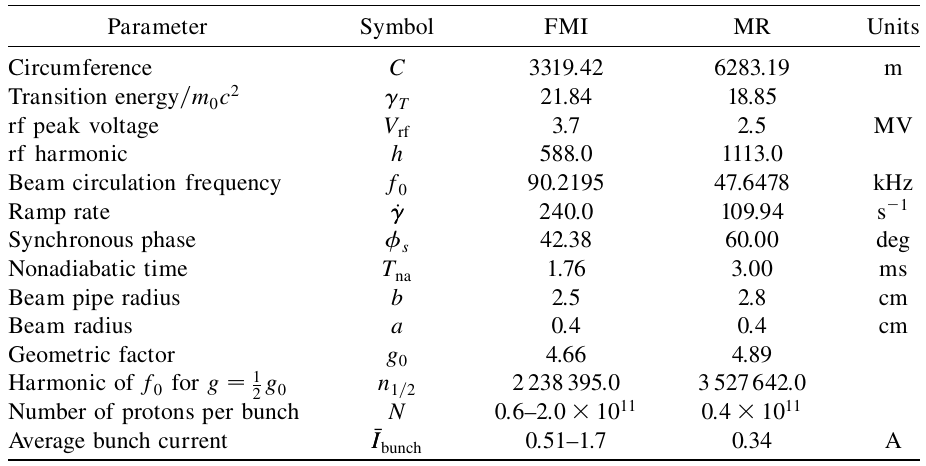
TABLE I. Ring parameters used in the